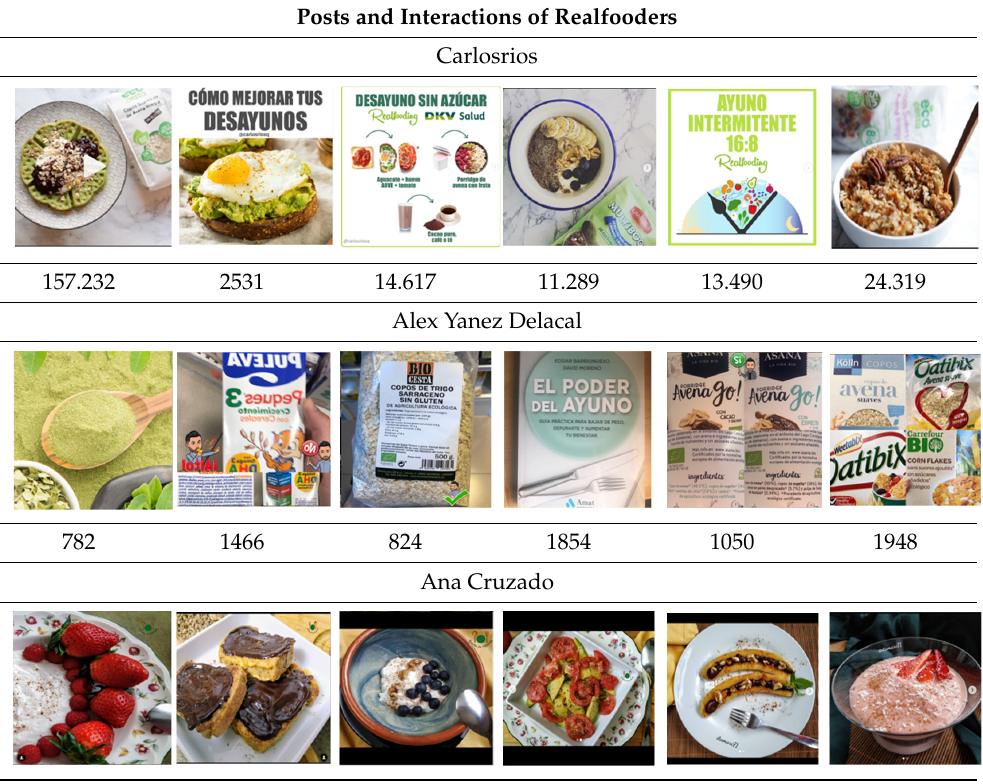
Table 2. Posts and interactions of Realfooders.